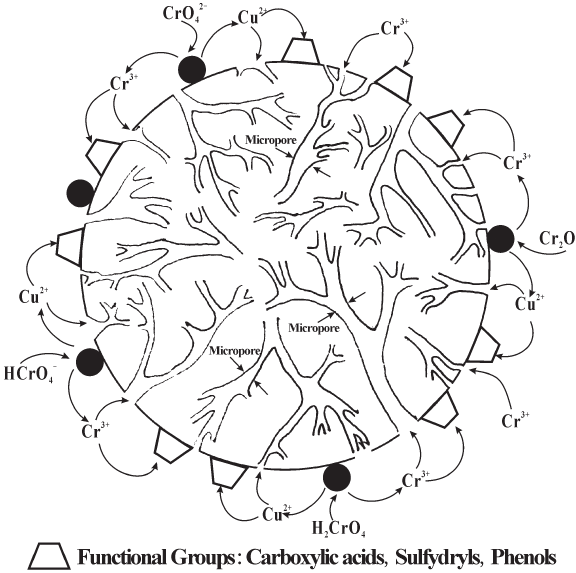
Figure 5: Mechanism of the adsorption for Cr(III) and Cr(VI) on Cu-